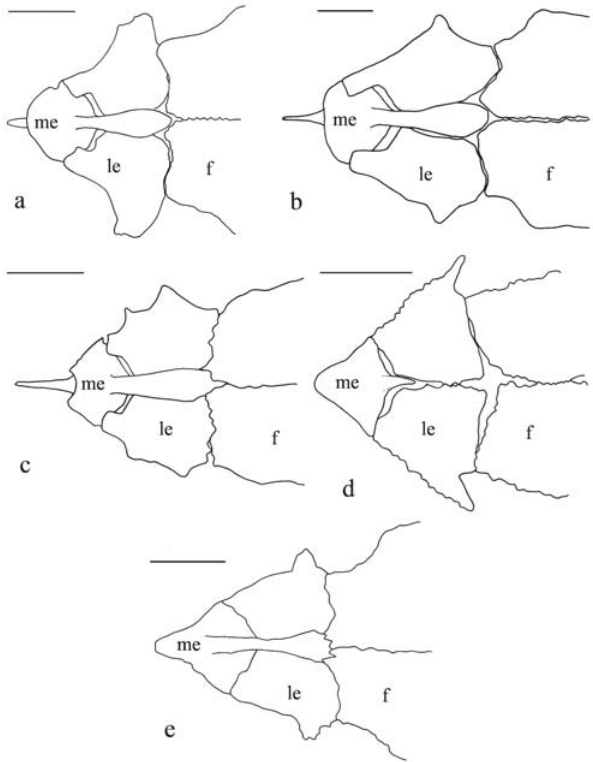
Fig. 4. Partial cranial osteology in Scoloplax . a, S. dicra ; b, S. distolothrix ; c, S . empousa ; d, S. dolicholophia ; e, S. baskini , INPA 28650, paratype, 11.8 mm SL. Anterior toward left. Ros- tral plate and lateral ethmoid plate removed. f = frontal; me = mesethmoid; le = lateral ethmoid. Scale = 0.5 mm. Figures a-d modified from Schaefer (1990).